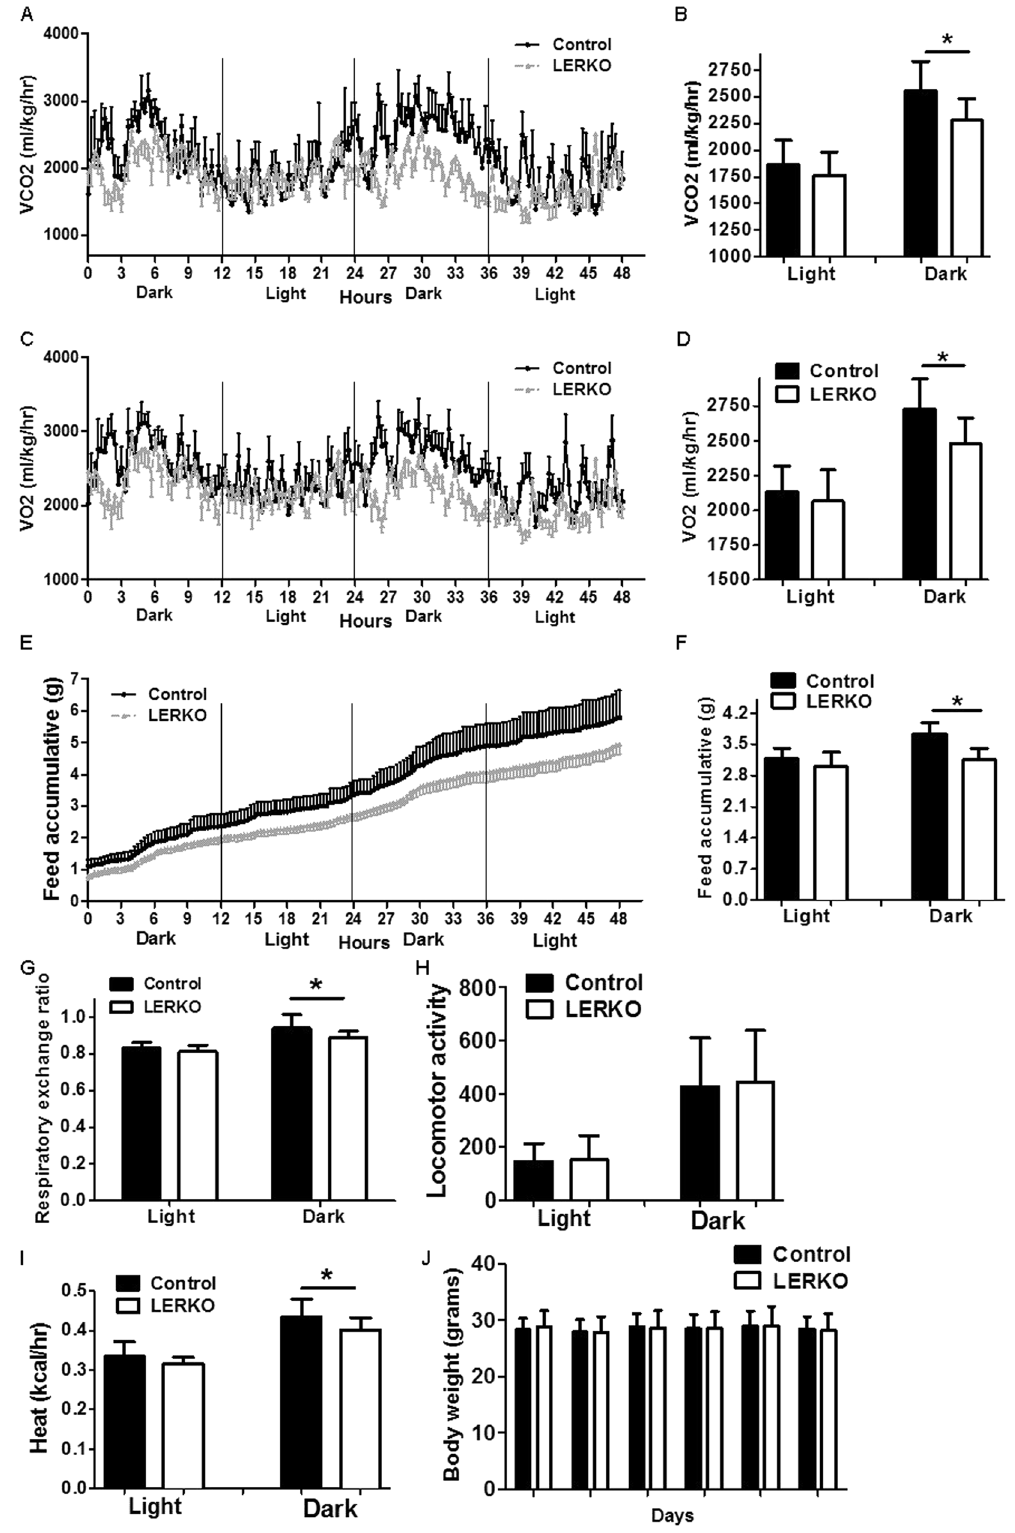
Figure 5. Reduced energy expenditure in LERKO mice. ( A ) Real-time monitoring curve of carbon dioxide release (VCO2). ( B ) Quantification of carbon dioxide release. ( C ) Real-time monitoring curve of oxygen consumption (VO2). ( D ) Quantification of O2 consumption. ( E ) Real-time monitoring curve of accumulated food intake. ( F ) Quantification of food intake. G, Respiratory exchange ratio (RER = VCO2/VO2) ( H ), Calculated body heat. ( I ) Locomotor activity. ( J ) Body weight measurement of Control group and LERKO group on GFP or CRE virus injection day 0, 4, 8, 12, 16. The experiments were performed 3 weeks after virus injection. Values are means ± SD. * p <